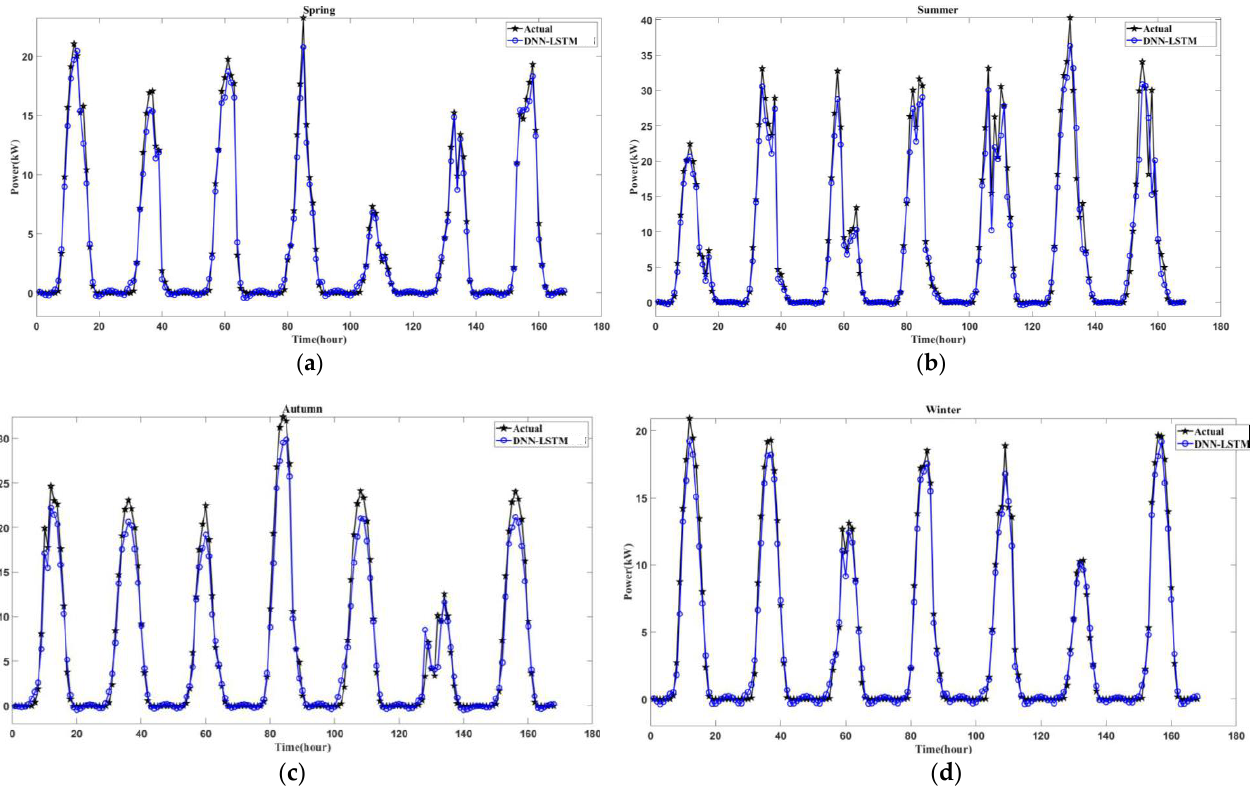
Figure 6. Hourly power generation forecasting results by DNN-LSTM during one week for solar power plant A: ( a ) spring; ( b ) summer; ( c ) autumn; ( d ) winter. Table 5. Comparisons of performance indicators of five forecasting models for solar power plant A.